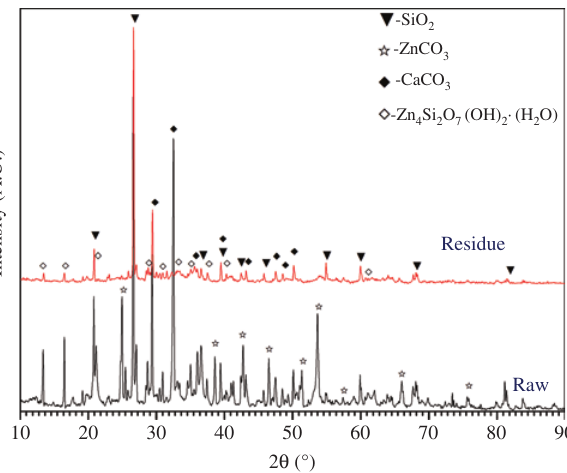
Figure 5: X-ray diffraction (XRD) patterns of leaching residue roasted at 673 K and the raw ore.